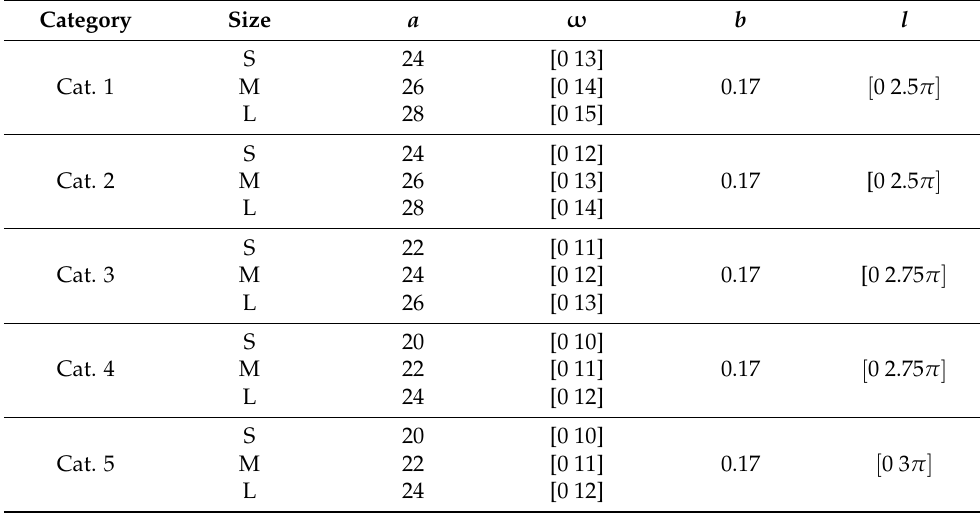
Table 3. Parameters used for constructing an improved logarithmic spiral